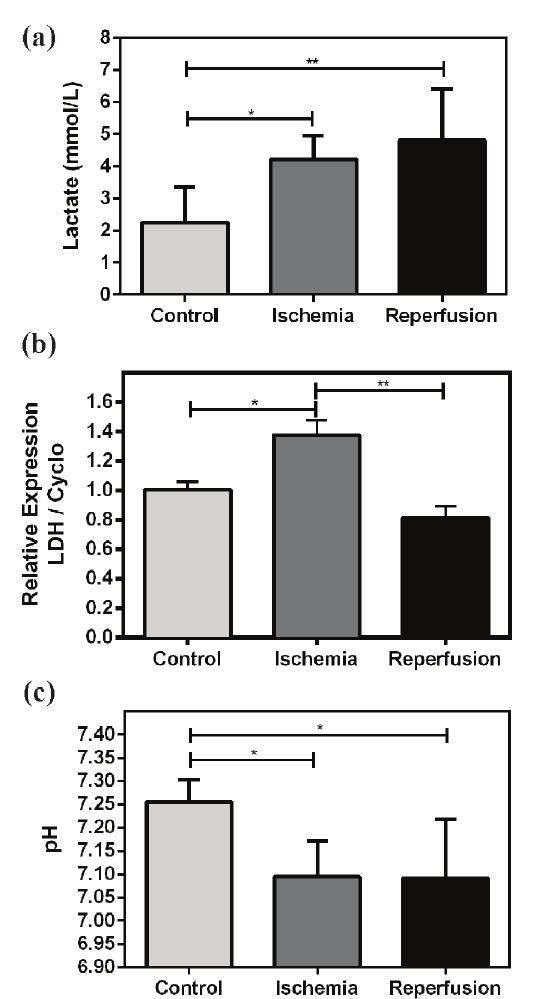
Figure 4 – Acidosis characterizes by the decrease of pH levels and lactemia and increased in Lactate dehydrogenase transcription. ( a ) Lactate levels were significantly higher in ischemia and reperfusion groups. ( b ) Lactate dehydrogenase transcription was significantly higher in ischemia group. ( c ) pH levels significantly reduced in ischemia and reperfusion groups. The statistical analysis used was ANOVA with Tukey post-test (*P<0,05) (n=5/group).